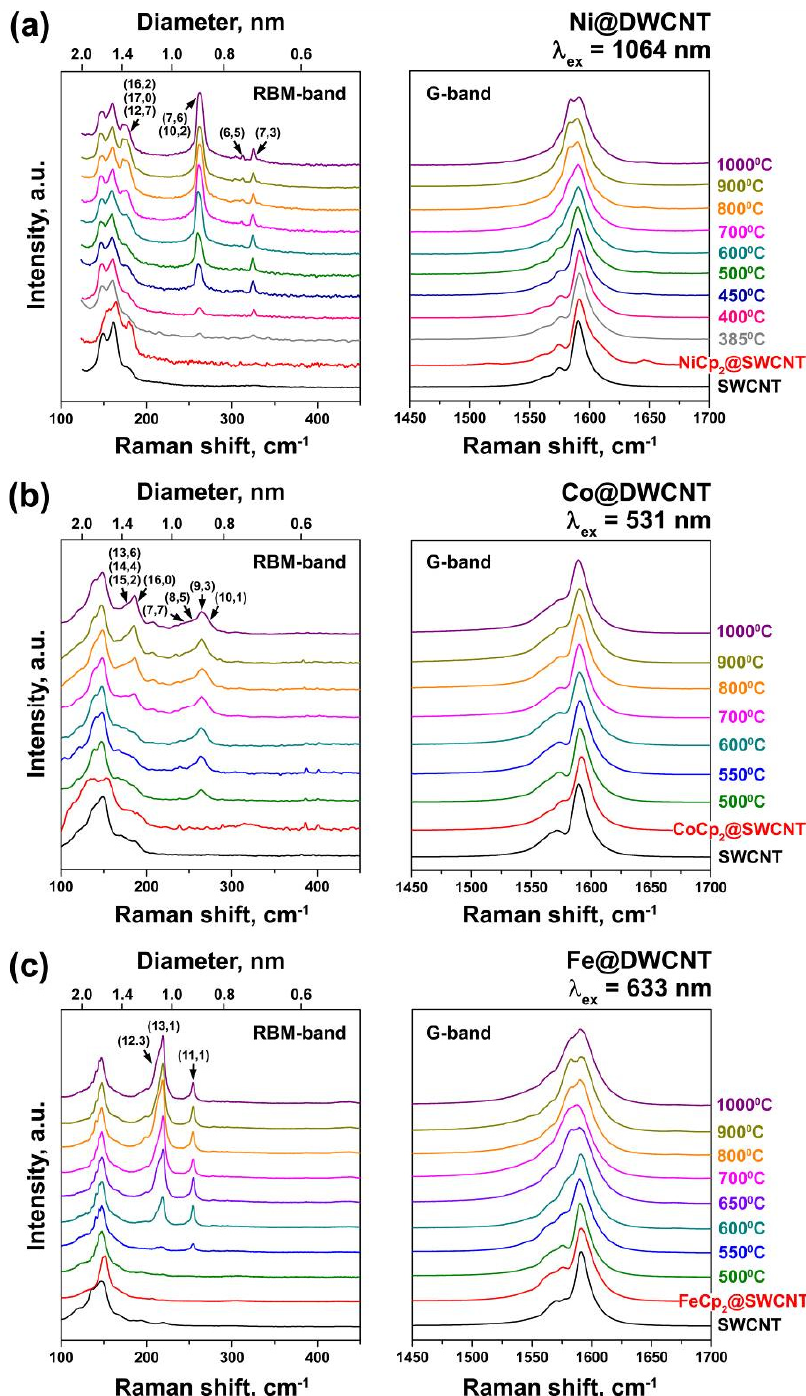
Figure 4. The RBM- and G-bands of Raman spectra of ( a ) the empty SWCNTs, the nanotubes filled with nickelocene and the filled SWCNTs heated from 385 to 1000 ◦ C for 2 h acquired with the 1064 nm laser (E ex = 1.17 eV), ( b ) the empty SWCNTs, the nanotubes filled with cobaltocene and the filled SWCNTs heated from 500 to 1000 ◦ C for 2 h acquired with the 531 nm laser (E ex = 2.34 eV) (reprinted with permission from Springer, Applied Physics A, Kharlamova et al., Growth dynamics of inner tubes inside cobaltocene-filled single-walled carbon nanotubes) [22]. Copyright 2016) and ( c ) the empty SWCNTs, the nanotubes filled with ferrocene and the filled SWCNTs heated from 500 to 1000 ◦ C for 2 h acquired with the 633 nm laser (E ex = 1.96 eV). The chiral indexes of inner tubes are